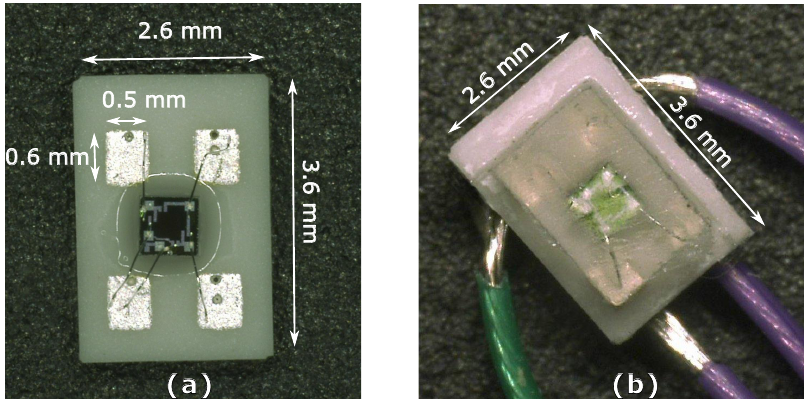
Figure 3. ( a ) Top view of the bare silicon pressure sensor die wire-bonded to the Ag/Pd electrical contact pads on a ceramic substrate; ( b ) silicone-packaged pressure sensor.